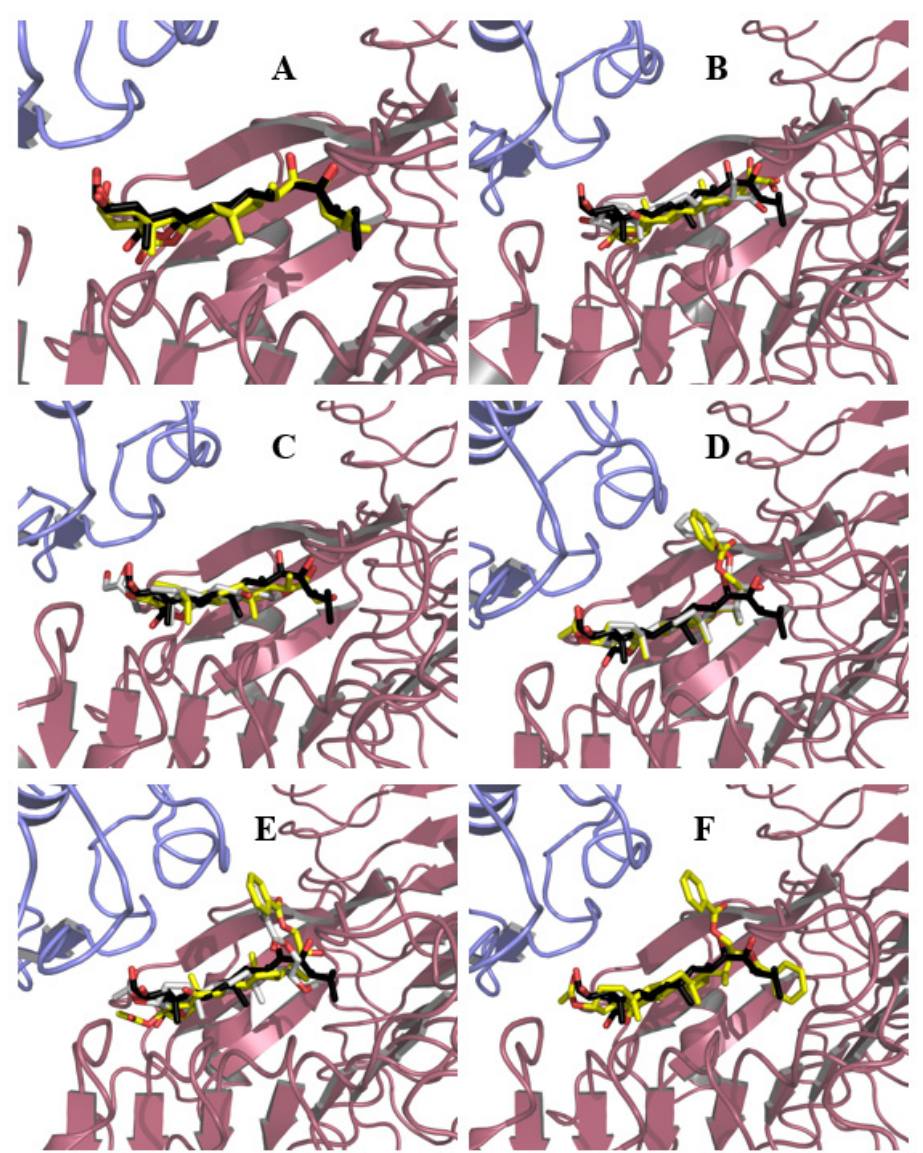
Figure 4. Binding modes of BL and synthetic ligands into BRI1 – BAK1 heterodimer. The BL crystal pose is shown in black and red sticks | BRI1 and BAK1 are represented as pink and blue cartoons, respectively. Binding modes #1 and #2 for ligands are represented as yellow and white sticks, respectively. ( A ) BL ( 1 , one binding mode); ( B ) Compound 3 (two binding modes); ( C ) Compound 4 (two binding modes); ( D ) Compound 6 (two binding modes); ( E ) Compound 7 (two binding modes); ( F ) Compound 8 (one binding